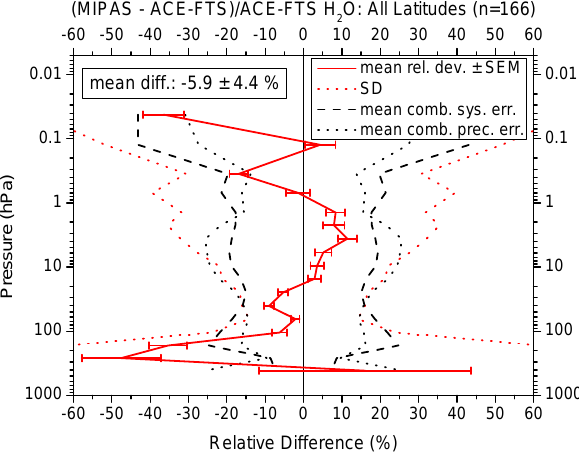
Fig. 17. Mean relative difference (including the standard error of the mean) of MIPAS and ACE-FTS H 2 O profiles (166 collocations) between 85 ◦ S and 85 ◦ N in February and March 2004. Systematic differences appear mainly in the hygropause region below 100hPa pressure altitude. The standard deviation is exceeding the expected combined precision error over most altitudes. Please note the much broader altitude range as compared to the SAGE-II comparisons. Annotation as per Fig. 13.